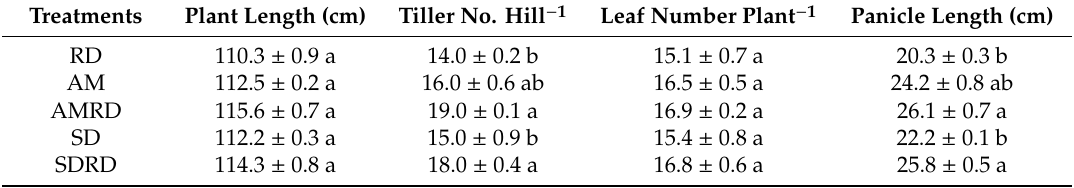
Table 3. Description of growth parameters under di ff erent treatments of fertilizer application. Treatments